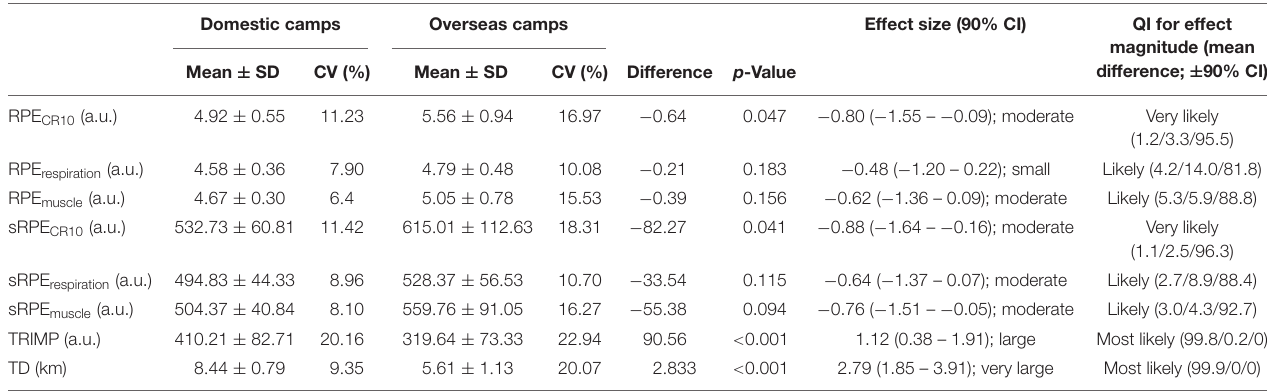
TABLE 3 | The perceived exertion of CR10, respiratory and muscular scales, training impulse, and total covering distance during the domestic and overseas training camps. Domestic camps Overseas camps Effect size (90%